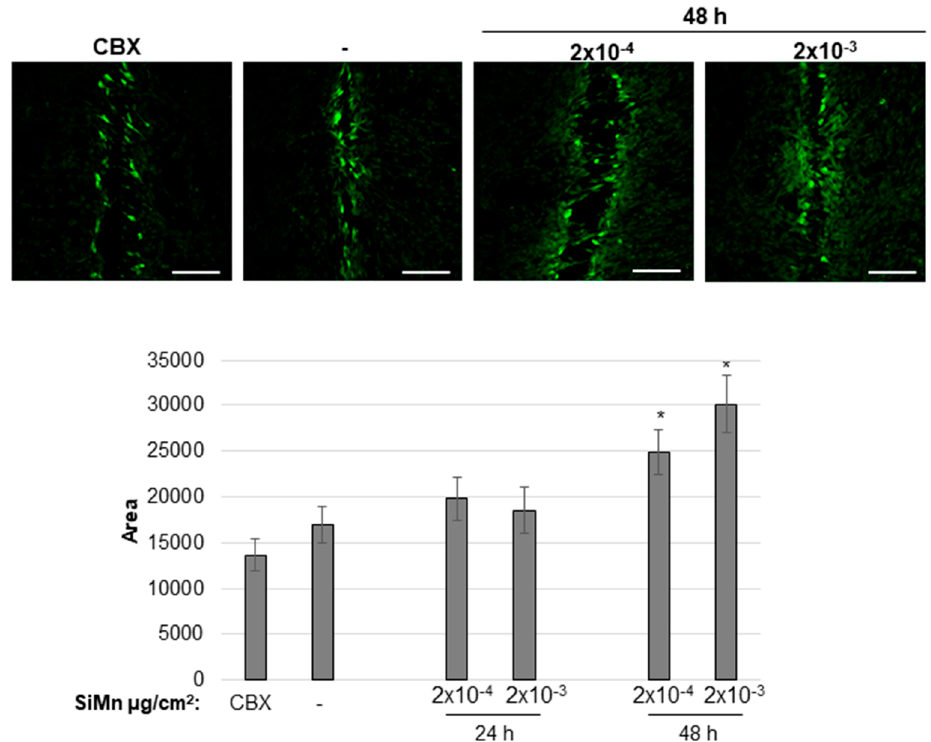
Figure 5. Gap junctional intercellular communication increases by SiMn dust exposure. Astrocytoma cells were grown on coverslips and exposed to dispersion media alone as a control or to the indicated doses of dispersed dust for 24 and 48 h. Carbenoxolone (CBX), an inhibitor of GJIC, was included in one well for each experiment as a control for dye uptake solely by the cut in the cell layer. Scrape loading was performed using Lucifer Yellow. Confocal microscopy was used to detect fluorescence and the levels of gap junctional intercellular communication were determined by means of the area of dye-coupled cells. Representative images are shown. Scale bar: 200 µ m. Quantification of three independent experiments is shown. Bars: SE. *: p ≤ 0.05 indicates a significant difference between exposed cells and the corresponding sham-treated control.